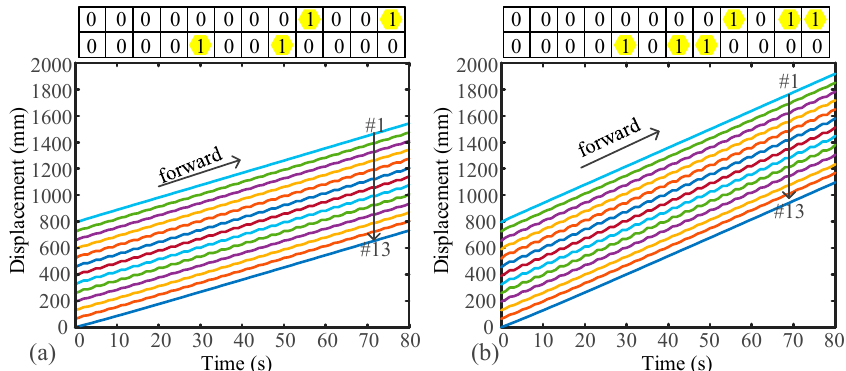
Figure 12. Locomotion simulations of a 12-segment earthworm-like robot based on B-DM with MG-I. The line located in the number is the locomotion tracks of the body segments. ( a ) The B-DM for four body segments has two actuated segments (“1001”). ( b ) The B-DM for four body segments has three actuated segments